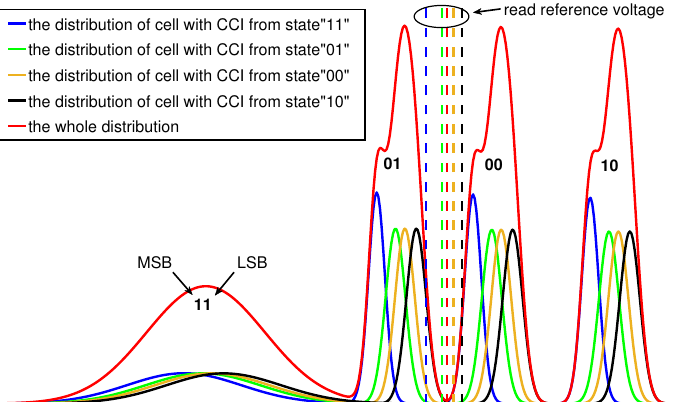
Figure 5. Illustration of the distribution of NAND flash memory at s = 1.4 (the cell-to-cell coupling strength factor), PE = 1 K and Retention time = 10 5 .